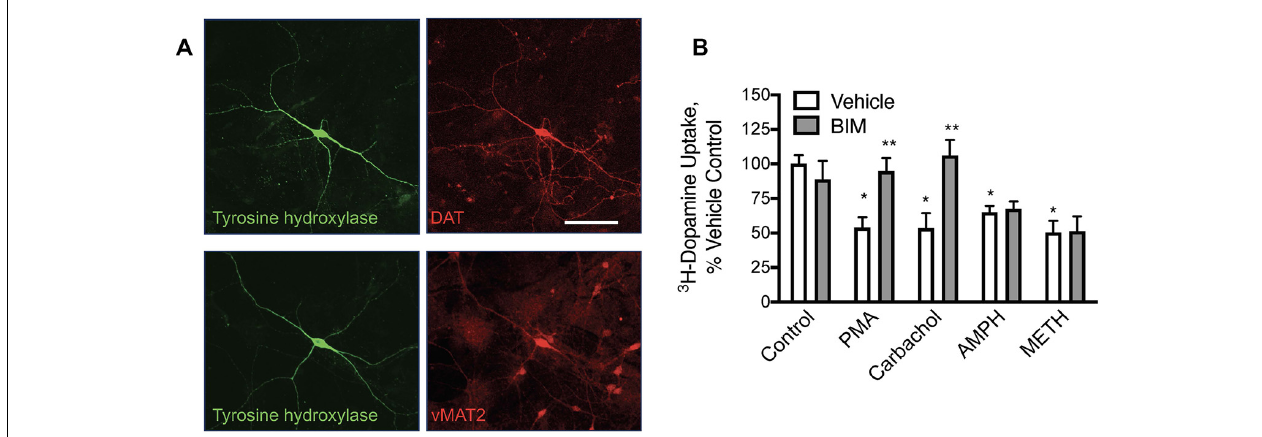
FIGURE 1 | In primary midbrain cultures, phorbol 12-myristate 13-acetate (PMA) and carbachol-mediated loss of dopamine transporter (DAT) function are protein kinase C (PKC) mediated while amphetamine (AMPH) and methamphetamine (METH)-mediated redistribution are not. (A) Primary midbrain cultures have dopamine (DA) neurons that express tyrosine hydroxylase (TH), DAT, and the vesicular monoamine transporter 2 (vMAT2; scale bar is 50 µ m). (B) Pre-treatment of these cultures with PMA (10 µ M), carbachol (30 µ M), amphetamine (10 µ M, AMPH), and methamphetamine (10 µ M METH) all decreased transport capacity of DAT (defined as GBR-12909 sensitive 3 H-dopamine uptake). Bisindolylmaleimide I (BIM, 1 µ M) inhibited the effects of PMA and carbachol, substantiating a PKC-mediated effect on DAT by these agonists. BIM did not alter the loss of DAT activity mediated by pretreatment with AMPH or METH indicating independent mechanisms of DAT internalization [ n = 3; * P < 0.01 from Vehicle control (first bar white bar) while ** P < 0.01 from own vehicle by two-way